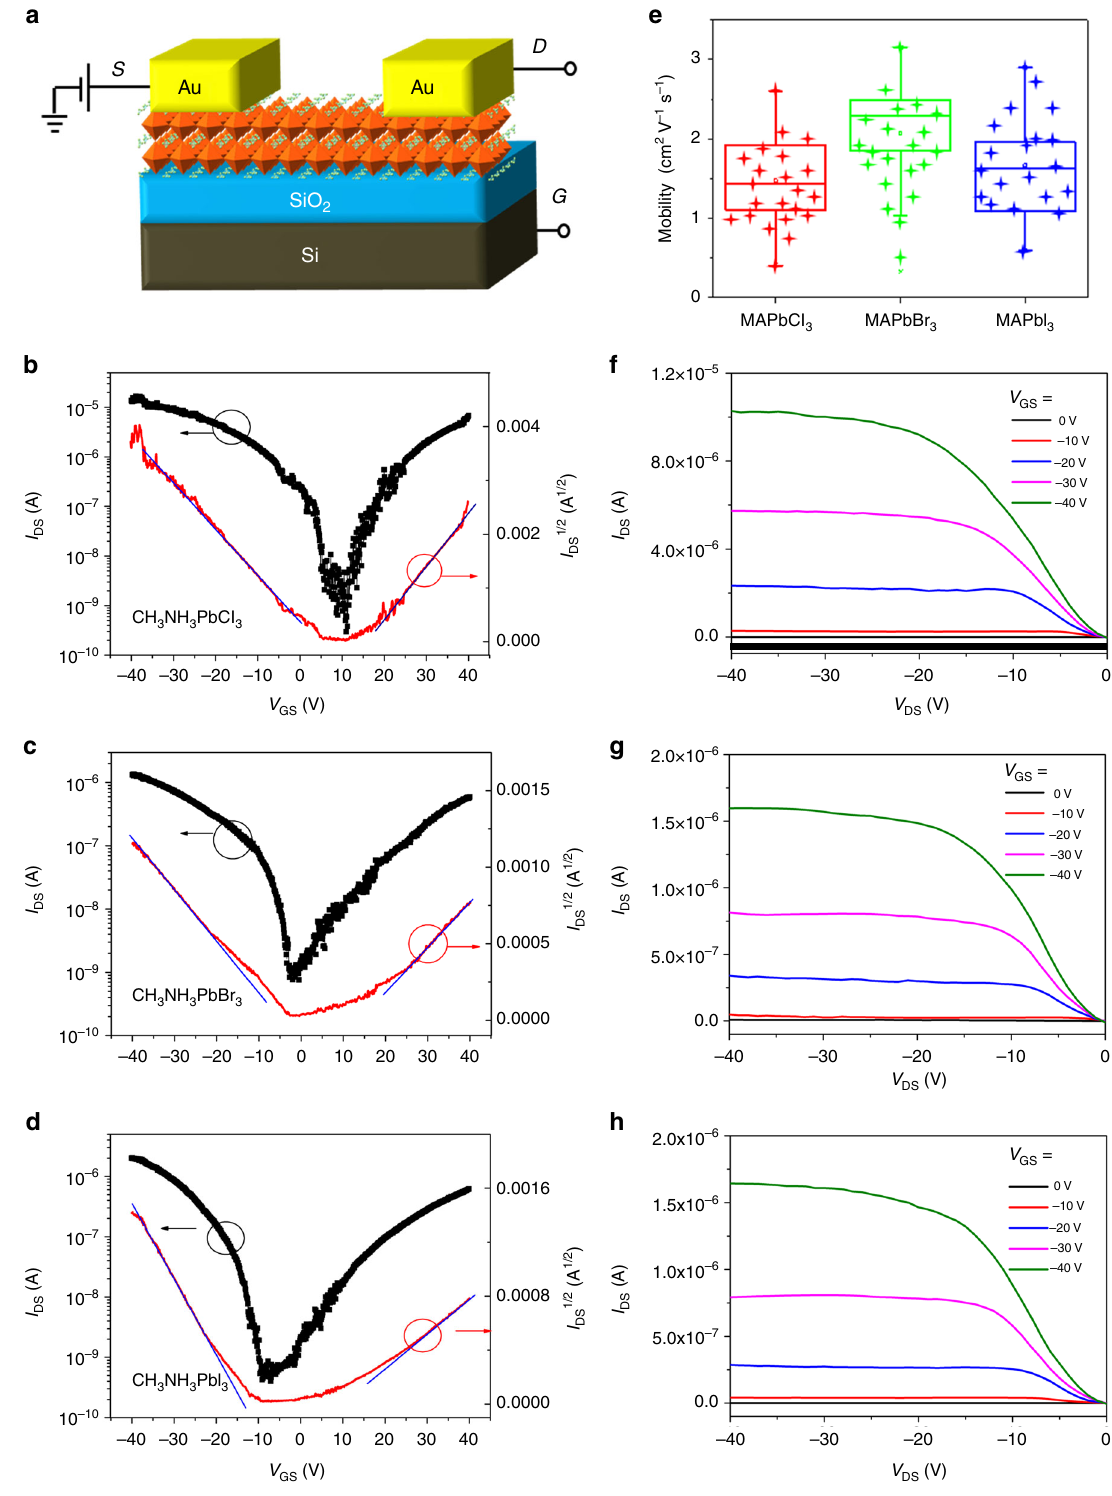
Fig. 3 Characteristics of top-contact TSC-FETs. a Schematic of the bottom-gate, top-contact (BGTC) device with a TSC hybrid perovskite as semiconductor layer. Transfer characteristics (I DS vs. V GS (black solid square) and I DS 1/2 vs. V GS (red solid line)), as well as the fi t lines (blue solid line) for b MAPbCl 3 , c MAPbBr 3 , and d MAPbI 3 TSC-FETs, V GS ranging from − 40 to 40 V. V DS = − 30 V. e Saturation mobility statistics for 60 devices. The box plot graphically depicts the statistical population of numerical data, including the maximum, the minimum, as well as the average (median) mobilities. Channel length: 50 μ m. Output characteristics of TSC-FETs based on f MAPbCl 3 , g MAPbBr 3 , and h MAPbI